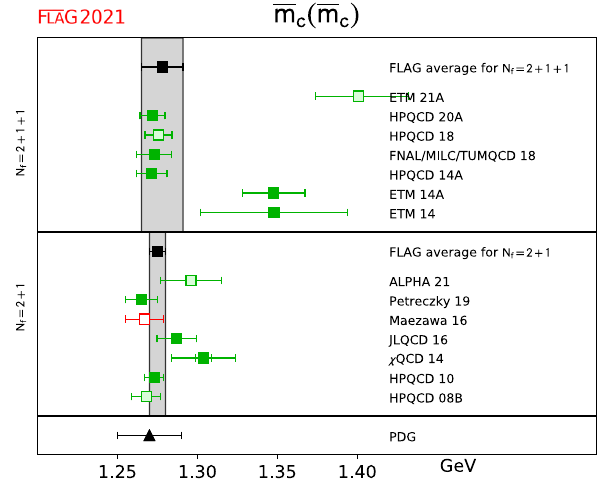
Fig. 5 The charm-quark mass for 2 + 1 and 2 + 1 + 1 flavours. For the latter a large stretching factor is used for the FLAG average due to poor χ 2 from our